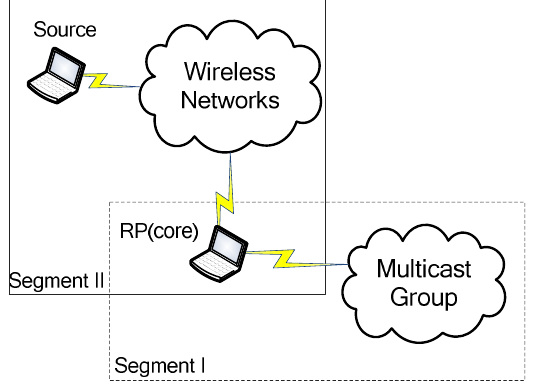
Fig.3. II-segment architecture of multicast routing